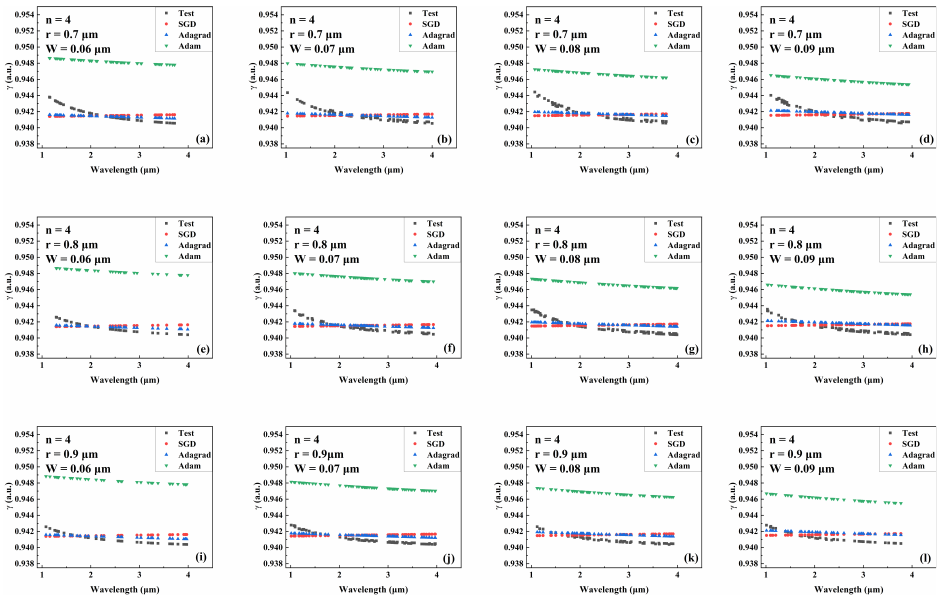
Figure 9. Comparision the predicted and actual values of γ in the test data set of the network model trained by different optimizers for different combinations of core radius and cantilever width (number of cantilevers: 4). ( a ) r = 0.7 µ m, W = 0.06 µ m. ( b ) r = 0.7 µ m, W = 0.07 µ m. ( c ) r = 0.7 µ m, W = 0.08 µ